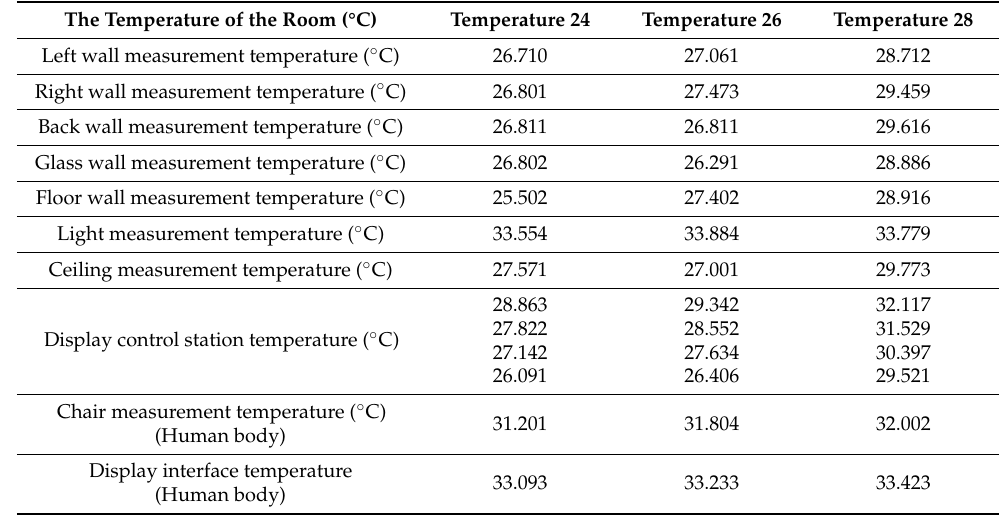
Table 8. Temperatures of select measuring points for experimental boundary conditions.